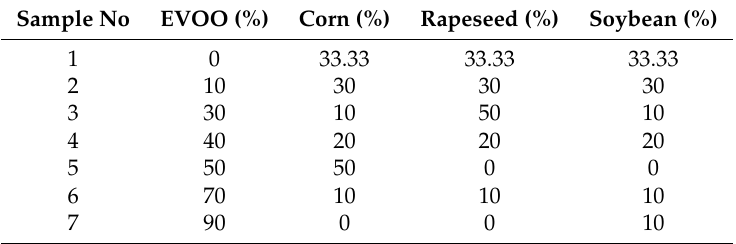
Figure 4. Actual concentration vs. estimated concentration of extra virgin olive oil (EVOO), corn oil, rapeseed oil and soybean oil calculated from quaternary mixtures of EVOO, corn, rapeseed and soybean oil ( v / v %) using non-negative least squares. The solid line represents the zero-error curve. Table 1. The actual concentrations of EVOO, corn, rapeseed and soybean oil used in the bar plot (Figure